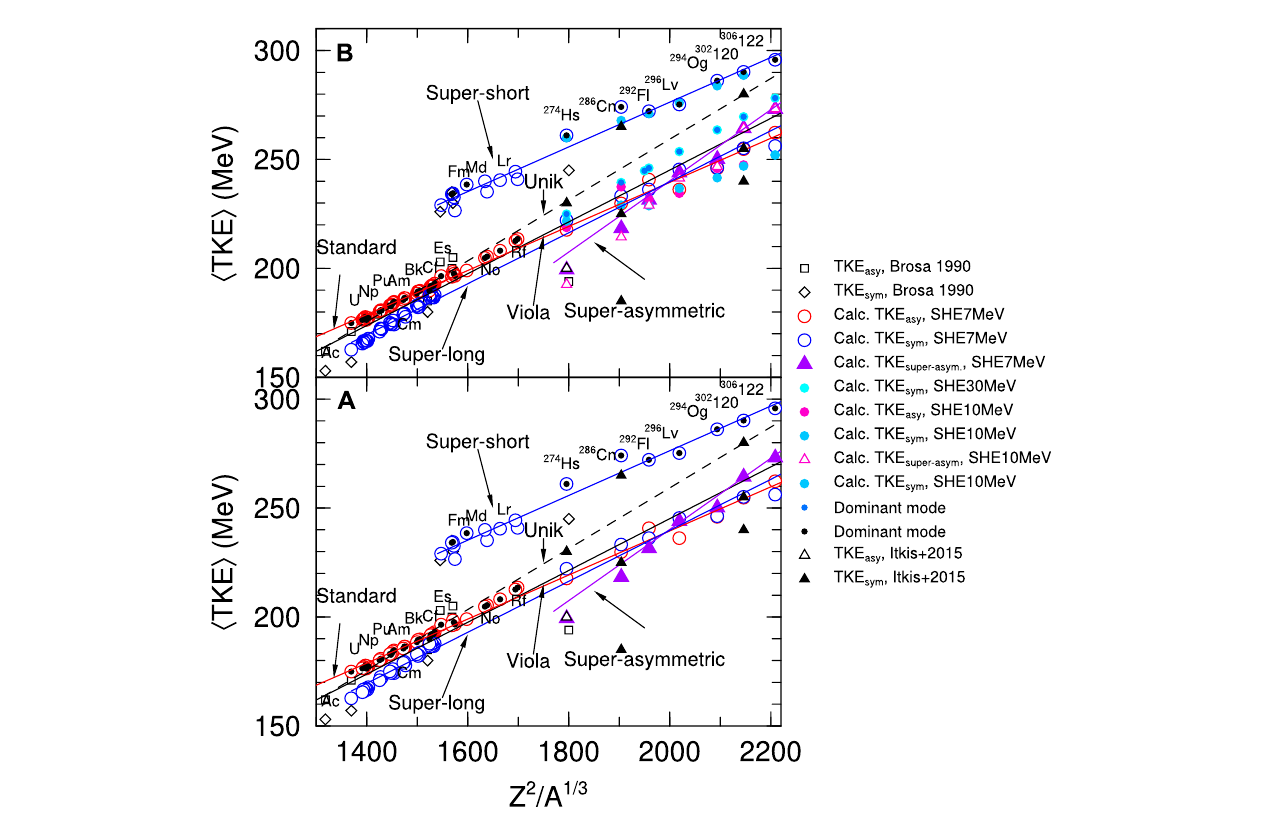
FIGURE 7 The systematics in averaged TKE as a function of Z 2 / A 1/3 . (A) TKE systematics at E x = 7 MeV. (B) The same plot as (B) but at E x = 7, 10, and 30 MeV.